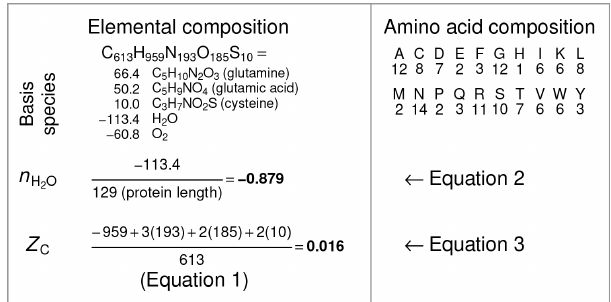
Figure 2. Schematic of calculations of n H and Z C for a sin- 2 O gle protein. The selected protein is chicken egg white lysozyme (UniProt ID: LYSC_CHICK), which is historically an extensively characterized protein in the laboratory. The protein sequence was used to tabulate the amino acid composition (right column), which in turn was used to generate the elemental composition (left col- umn). The coefficients on the basis species are determined from the elemental composition by mass-balance constraints. Dividing the number of H 2 O in the basis species by the protein length gives the stoichiometric hydration state ( n H ). Independent of the ba- 2 O sis species, the elemental composition yields the average oxidation state of carbon ( Z C ) according to Eq. (1). To reduce computing steps, in this study the amino acid compositions of proteins (ob- tained, for example, from metagenomic sequences) were used to calculate n H and Z C with Eqs. (2) and (3) and the values for 2 O amino acids in Table